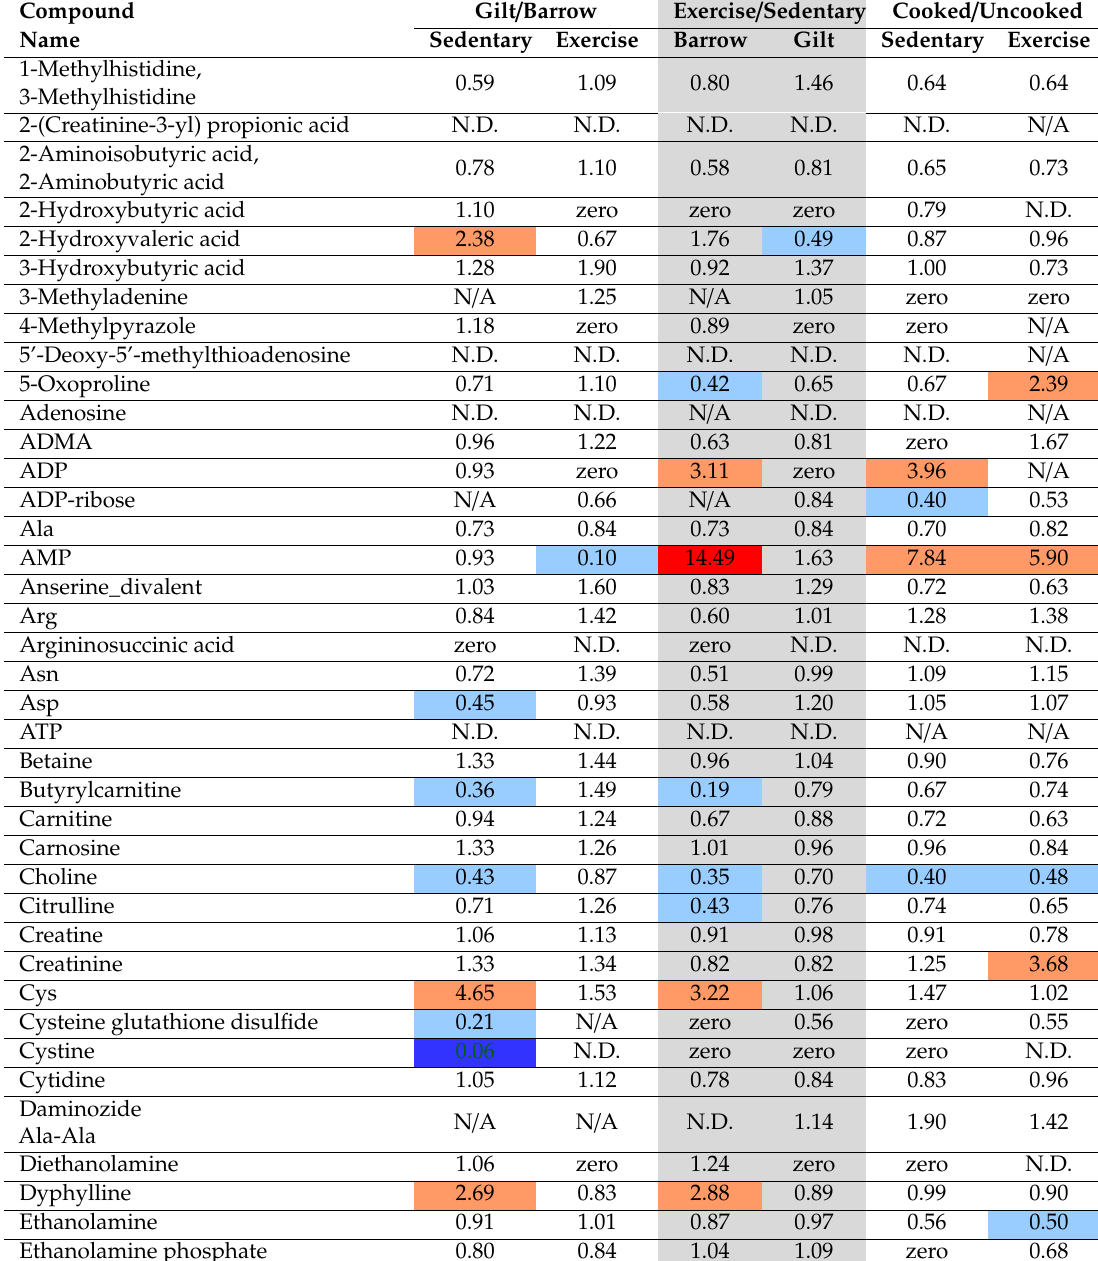
Table 1. Metabolite ratios in the three di ff erent conditions. Numbers in the red boxes are a ratio of > 2 and those in blue boxes are a ratio of < 0.5. The intensity of the color corresponds to the magnitude of the ratio < 0.1 or >